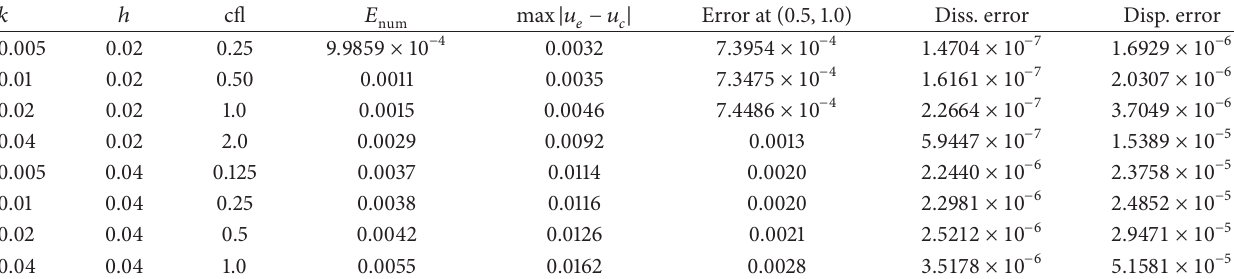
Table 2: Errors for Crank-Nicolson scheme.